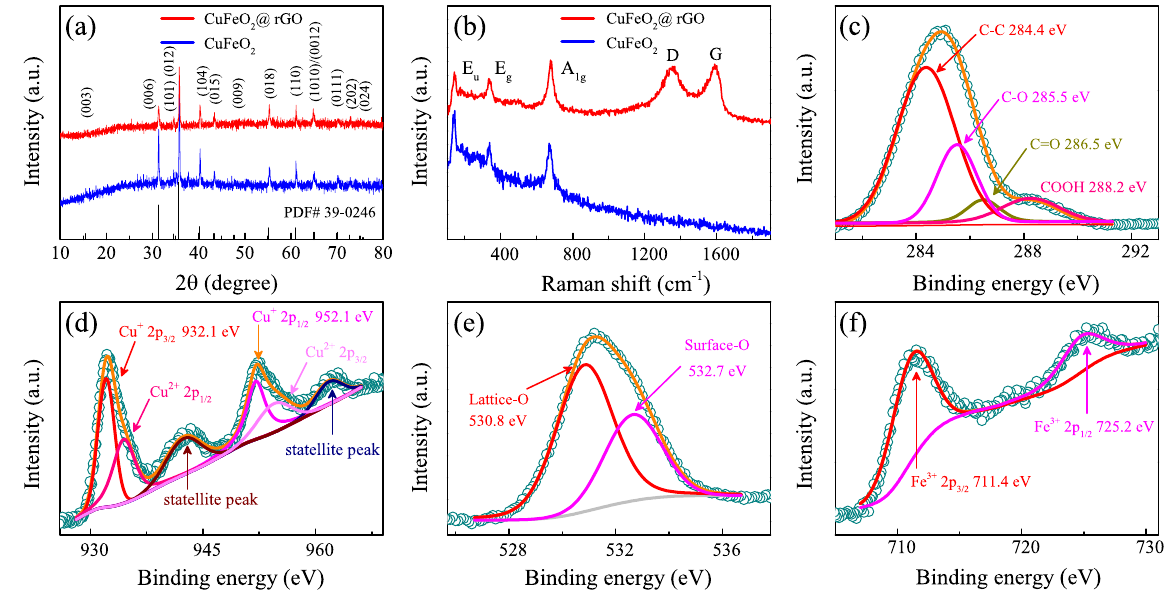
Figure 2. ( a ) XRD patterns and ( b ) Raman spectra of CuFeO 2 and CuFeO 2 @rGO. High-resolution XPS spectra of ( c ) C 1 s , ( d ) Cu 2 p , ( e ) O 1 s , and ( f ) Fe 2 p for CuFeO 2